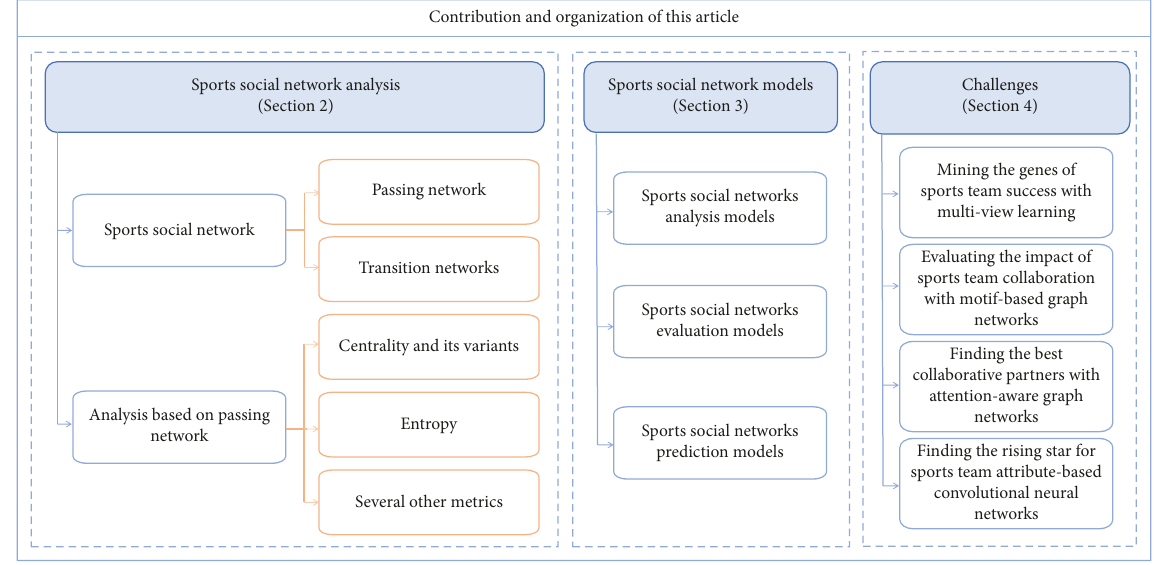
Figure 1: Contribution and organization of this article.